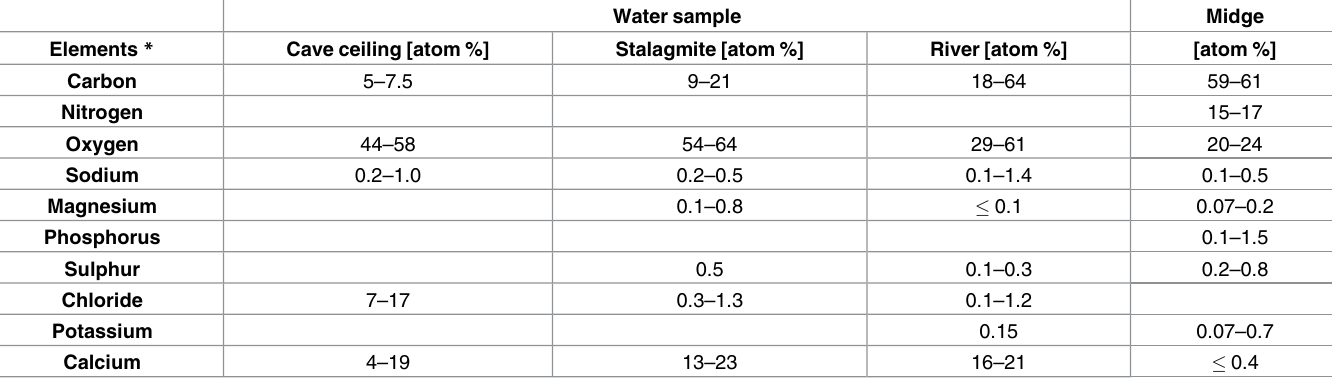
Table 2. EDX values of the different elements and chemicals, given in atomic%, present in the water within the Spellbound cave.